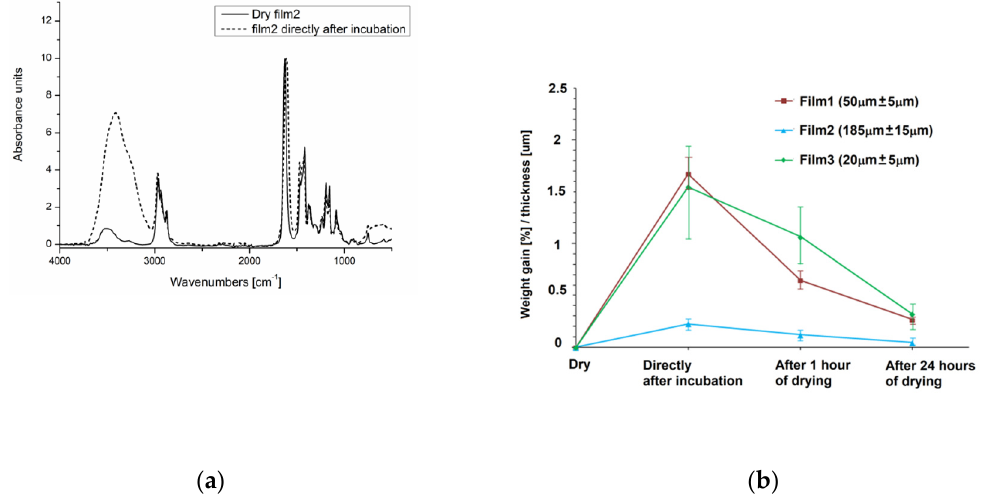
Figure 5. ( a ) FT-IR spectra of Film 2 in the dry state and directly after incubation in water at 40 °C; and ( b ) the weight gain of the P(iPrOx-nPrOx) films relative to their thickness after incubation. In the spectrum of the dry film, characteristic absorption bands of polyoxazoline are observed. H deformation), 1362–1380 cm − 1 (C-N stretch), 1160–1200 cm − 1 (C–H deformation), and 1088 cm − 1 (C–